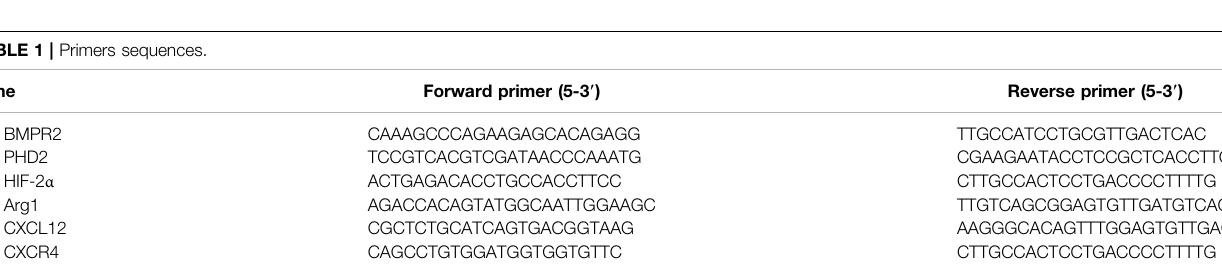
TABLE 1 | Primers